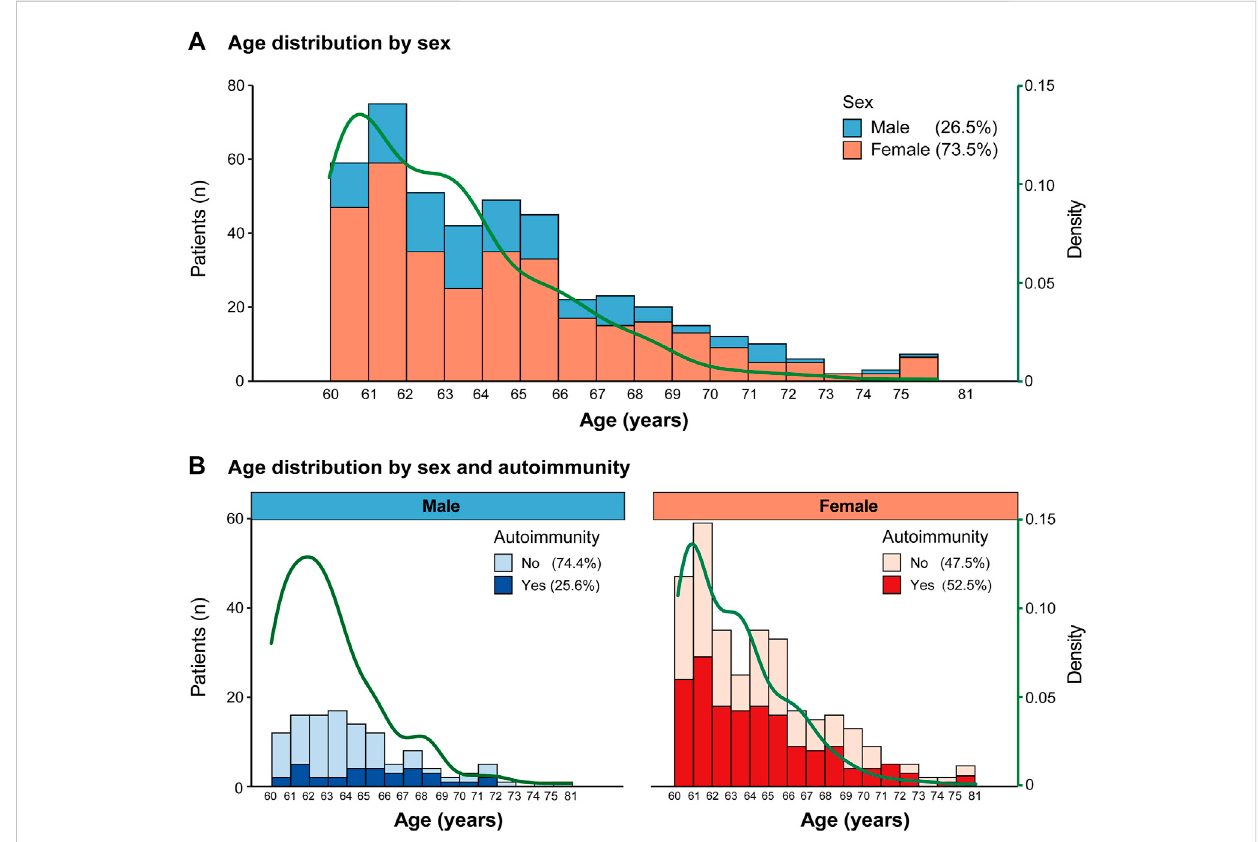
FIGURE 2 Age distribution (A) . Age distribution by sex; (B) . Age distribution by sex and